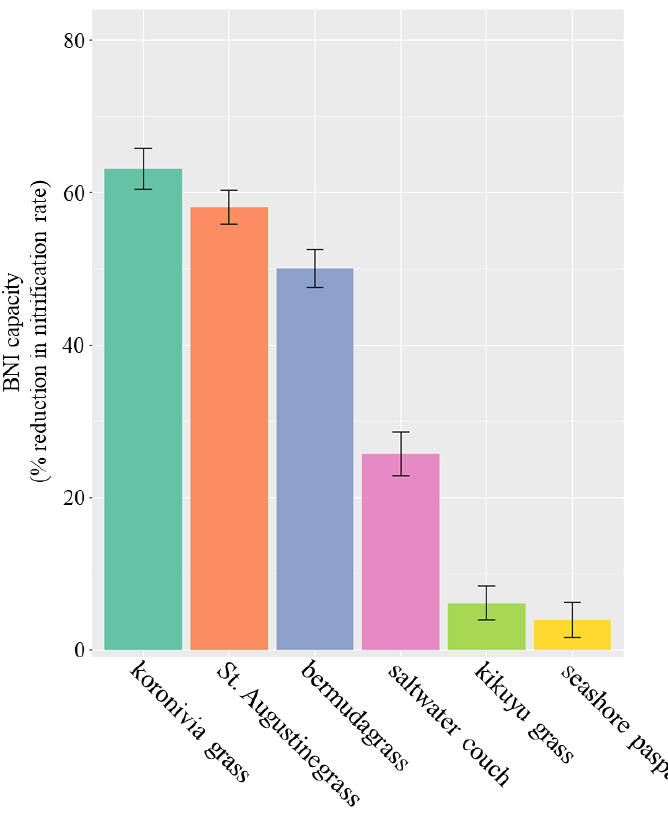
Figure 1. Biological nitrification inhibition (BNI) capacities of six perennial grasses. BNI capacity was measured by the reduction in potential nitrification rate in grass rhizosphere soil compared with the bulk soil. The error bar indicates standard error of four biological replicates at p = 0.05.